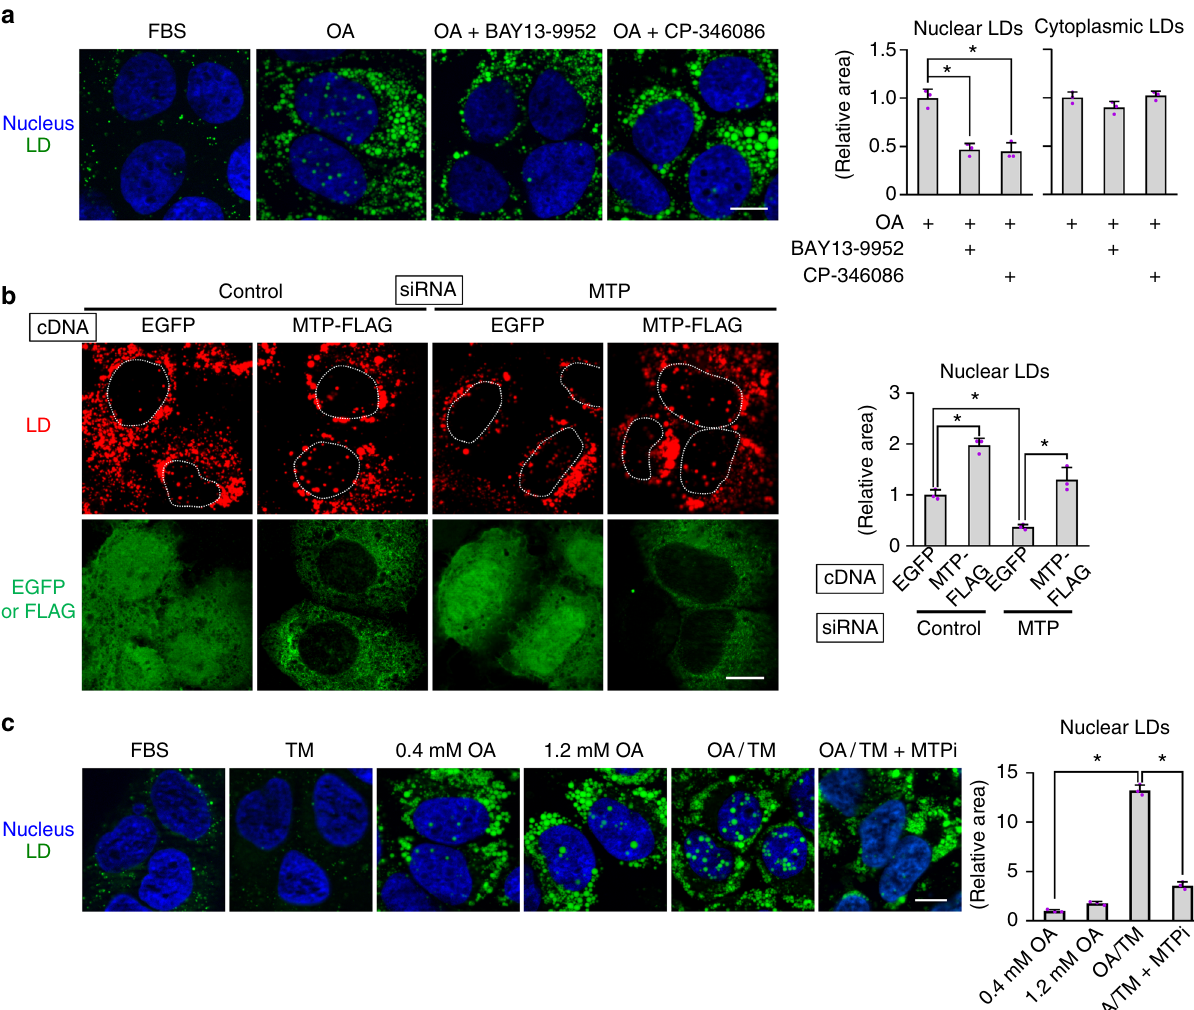
Fig. 1 Downregulation of MTP suppresses nuclear LD formation. a MTP inhibitor (MTPi) suppressed the increase of nuclear LDs, but not that of cytoplasmic LDs. Huh7 cells were treated for 24 h with 0.4 m M OA with or without an MTPi, 100 n M BAY 13-9952, or 100 n M CP-346086. LD (green), nucleus (blue). b MTP knockdown suppressed nuclear LD formation. Huh7 cells were treated with either control or MTP siRNA, transfected with cDNA of either EGFP or MTP-FLAG, and cultured with 0.4 m M OA for 24 h. MTP-FLAG not only canceled the effect of MTP knockdown, but also increased the nuclear LDs signi fi cantly over the control level. See also Supplementary Fig. 1b. c OA/TM (0.4 m M OA and 5 μ g/ml TM) induced a drastic increase of nuclear LDs in Huh7, and the increase was suppressed by MTPi. Although treatment with 1.2 m M OA caused an increase of nuclear LDs, treatment with TM (5 μ g/ml) alone did not. a – c Mean ± SD of three independent experiments. * p < 0.01, one-way ANOVA followed by Tukey's test. Bars, 10 μ m. Source